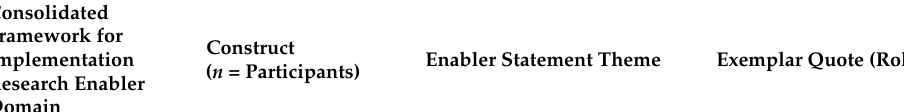
Table 2. Enabler coding